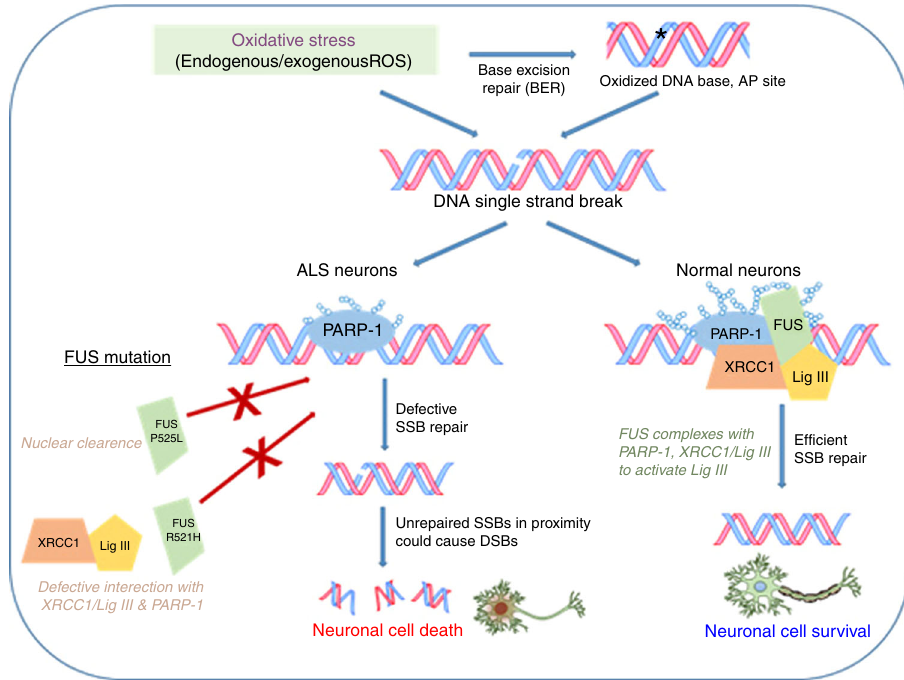
Fig. 9 Mutant FUS induces DNA ligation defects to inhibit oxidized damage repair. A model showing the involvement of FUS for optimal DNA nick ligation in healthy neurons to facilitate ef fi cient oxidative genome damage repair, and how loss of functional FUS in ALS leads to DNA nick ligation defects. FUS is required for PARP-1-dependent recruitment of XRCC1/LigIII complex at oxidative DNA damage sites. Two familial FUS mutations impair DNA nick ligation by distinct mechanisms. Substantial cytoplasmic localization of P525L FUS causes DNA ligation defect due to loss of functional FUS from nucleus. The R521H/C FUS fails to form the repair complex with XRCC1/LigIII and PARP-1 and is not recruited at damage site. Unrepaired DNA SSBs caused by impaired DNA nick ligation, together with secondary DSBs that may be generated from closely placed single-strand breaks, may substantially contribute